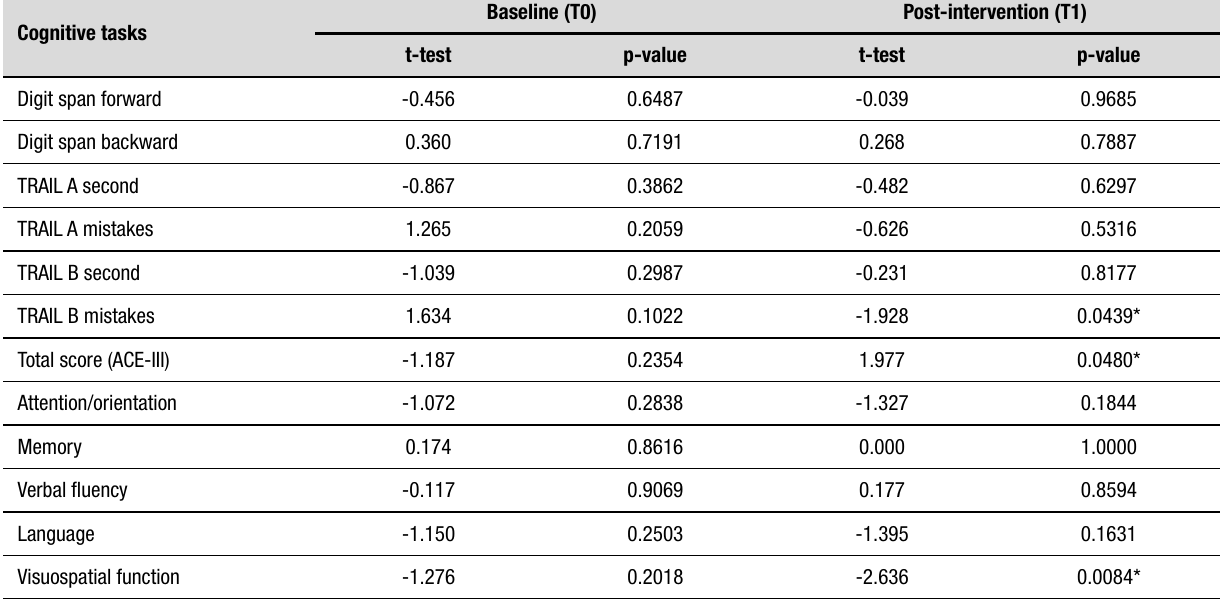
Table 3. Inferential analysis — experimental x control.